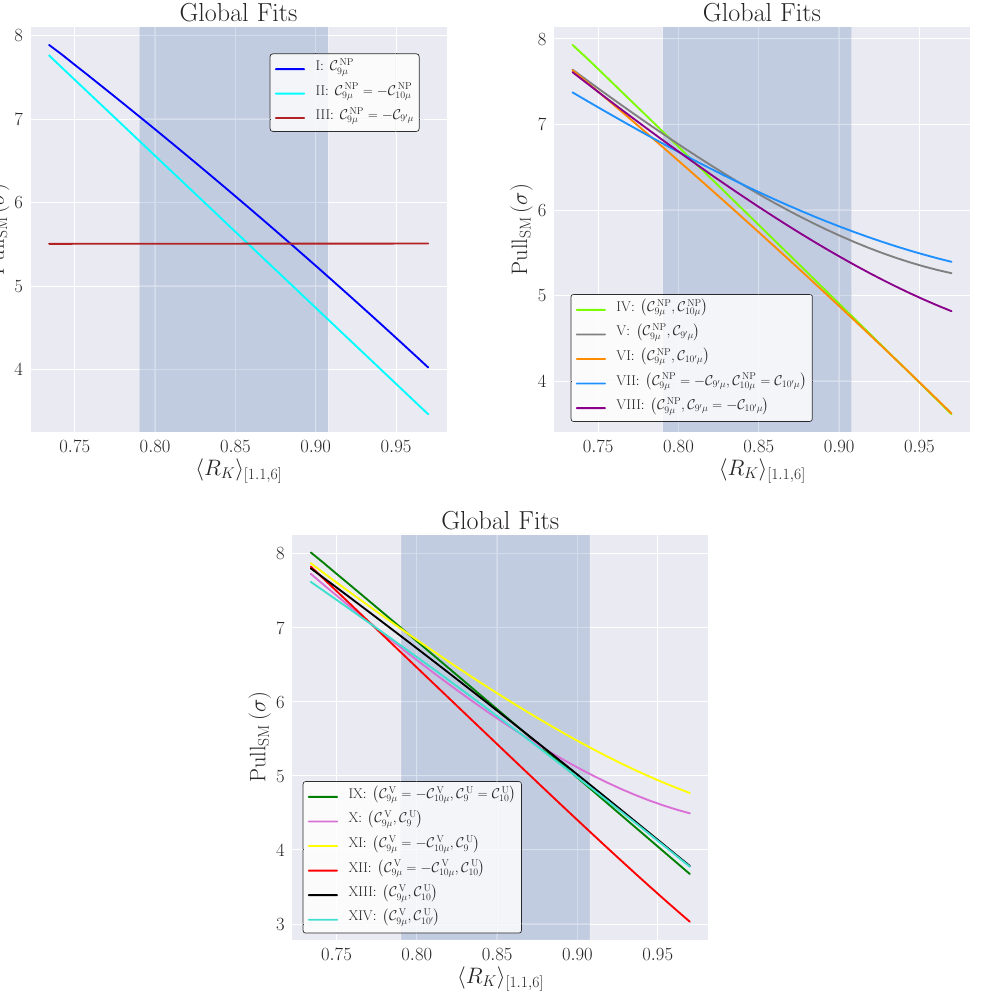
Figure 4. Global fit: impact of the central value of under